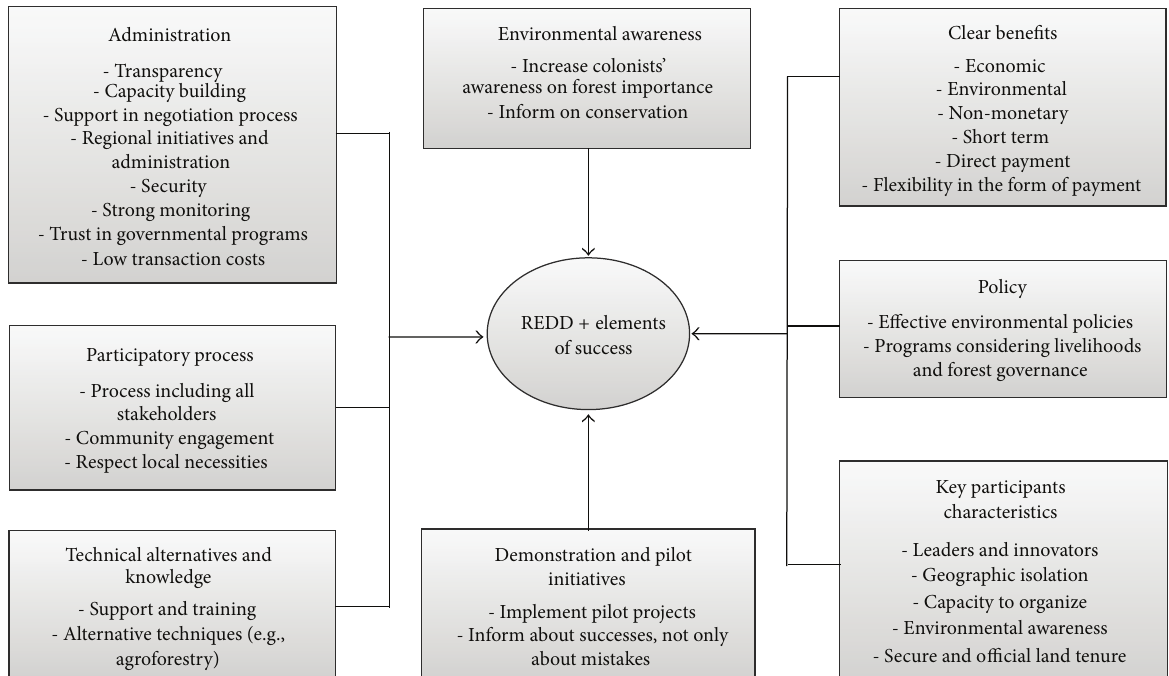
F 3: Synthesis of the elements of success for REDD+ implementation in colonist areas that were identi�ed by the different groups of actors during phase